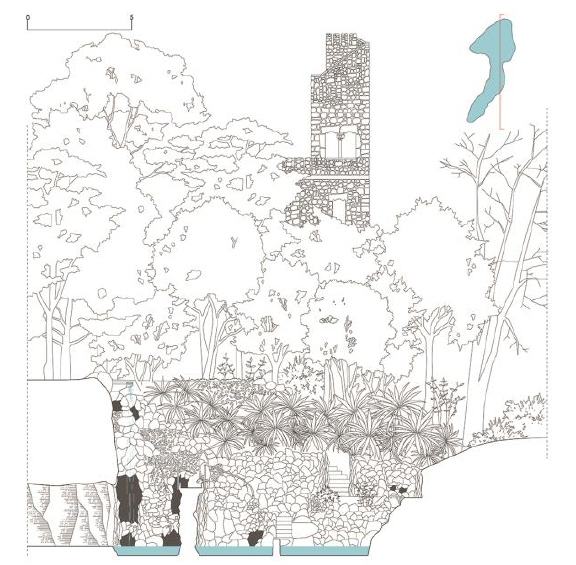
Figure 5 . The Quinta da Regaleira in Sintra, the Lago da Cascata , cross